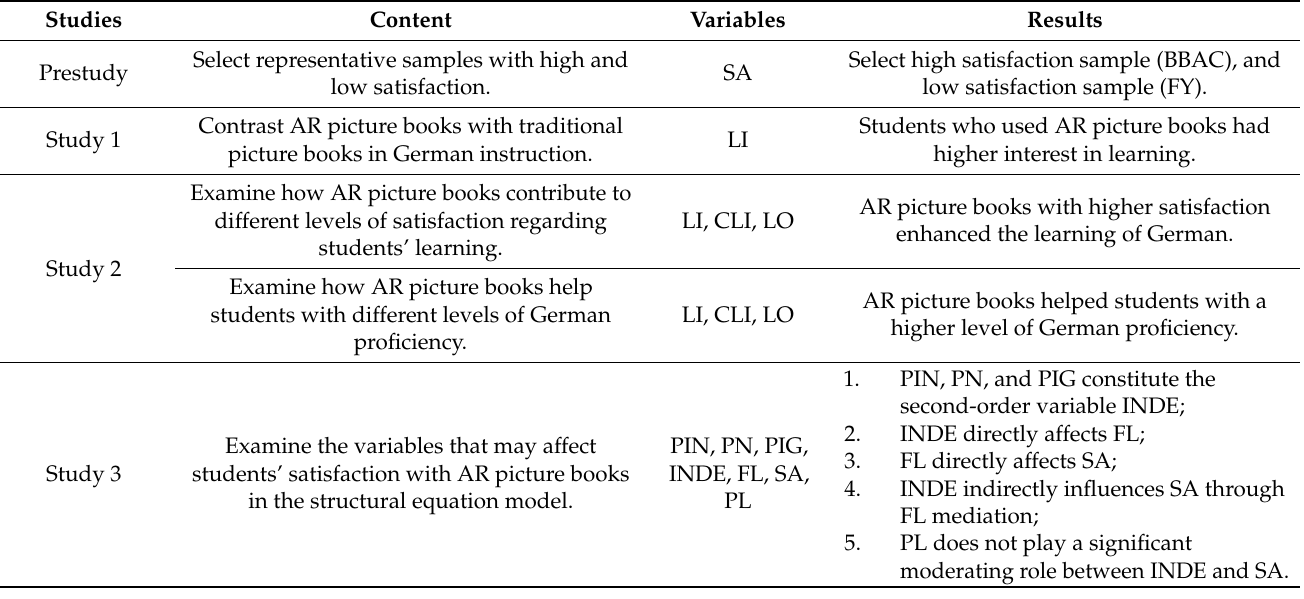
Table 14. Summary of survey